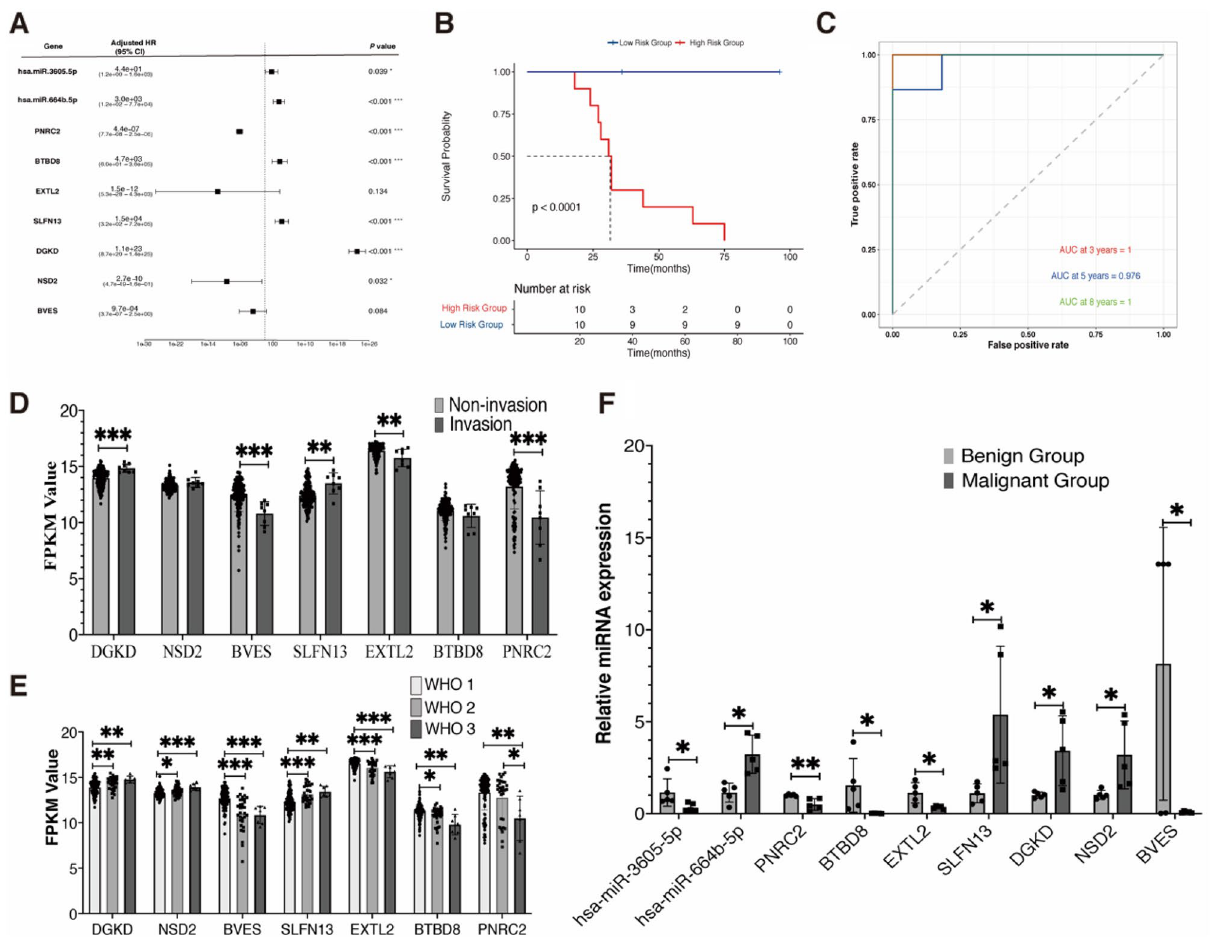
Figure 4. Identification and validation of nine MPRGs-based prognostic factors. ( A ) Forest plot of the impact of MPRGs-based prognostic factors on overall survival (OS); ( B ) Kaplan–Meier OS curve of high- and low- risk groups based on the risk score in the group; ( C ) Time-dependent ROC curves in our cohort; ( D , E ) The expression profile of seven MPRGs-based mRNAs between invasion group samples and no invasion group or among WHO grades samples in 157 meningioma tumors from the GEO136661 dataset. ( F ) Expression level of the nine MPRGs-based prognostic factors between malignant group samples and benign group samples were analyzed using qRT-PCR, U6 and GAPDH was set as internal control. Error bars represent the standard errors of independent samples. * P < 0.05, ** P < 0.01, *** P <